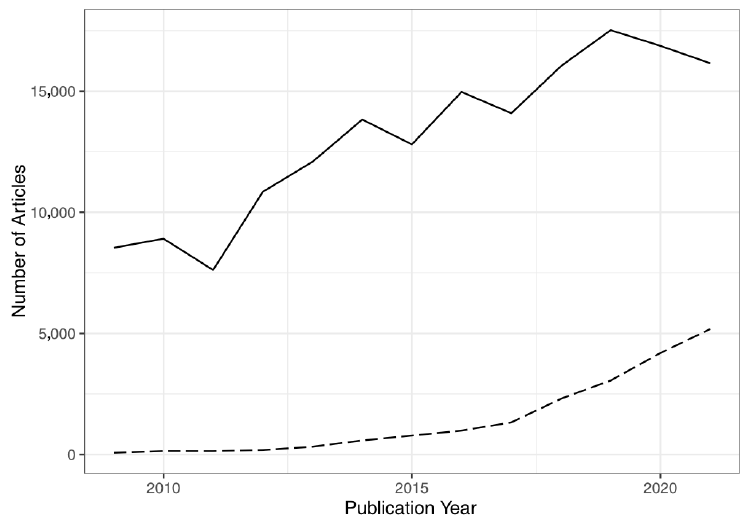
Figure 1. Articles published from 2009 to 2021 in the field of remote sensing according to the ‘Web of Science’ (solid line) and articles published in Remote Sensing (dashed